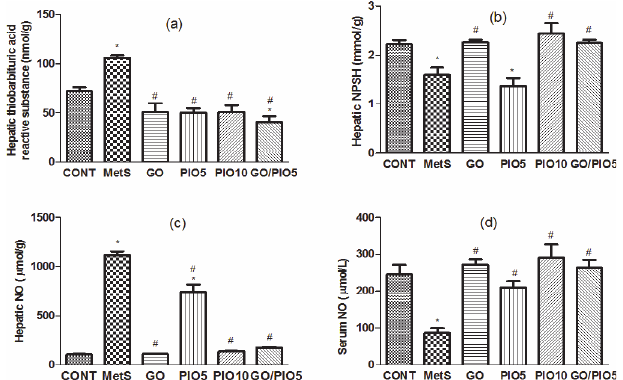
Fig 6. Effect of 4 weeks daily oral administration of geraniol (GO; 250 mg/kg), pioglitazone (PIO; 5 and10 mg/kg), and GO with PIO5 on hepatic (a) thiobarbituric acid reactive substance and (b) non protein thiols (NPSH), as well as hepatic (c) and serum (d) nitric oxide (NO) levels in fructose-induced metabolic syndrome (MetS) in rats. Values are mean (6 – 8 animals) ± SEM. P < 0.05, as compared to control (CONT) ( * ) and MetS ( # ) groups using one-way ANOVA followed by Tukey – Kramer